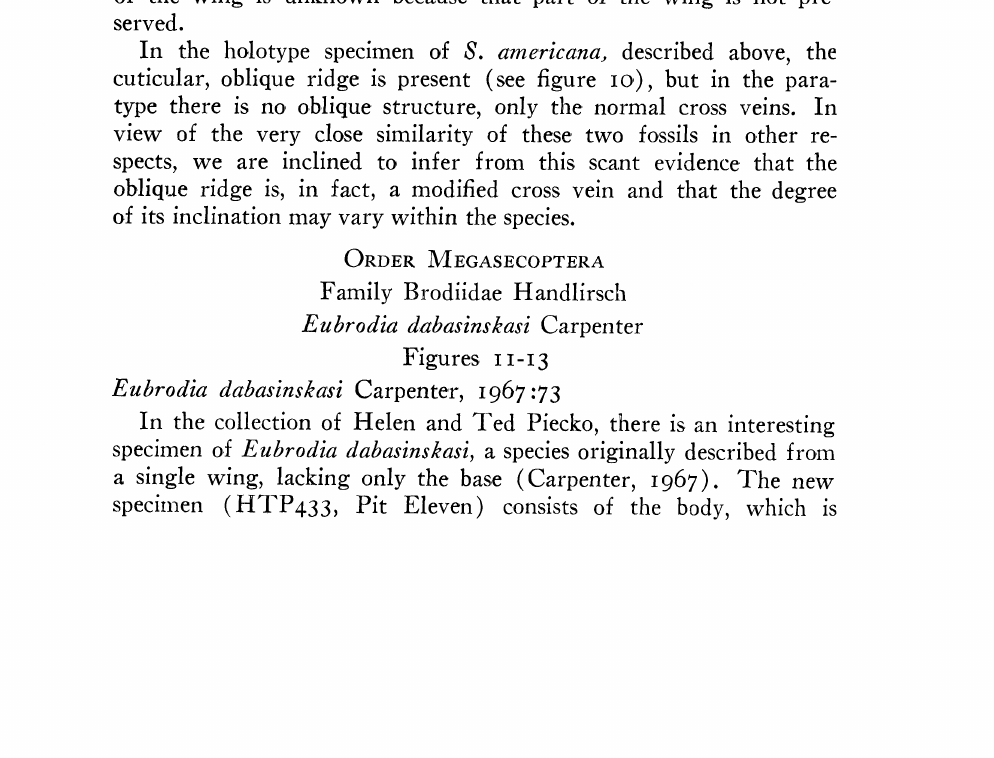
Figure 11. Eubrodia dabasinskasi Carpenter. Composite drawing of entire wing, based on specimen HTP 433, Pieeko eolleetion, and the holo-